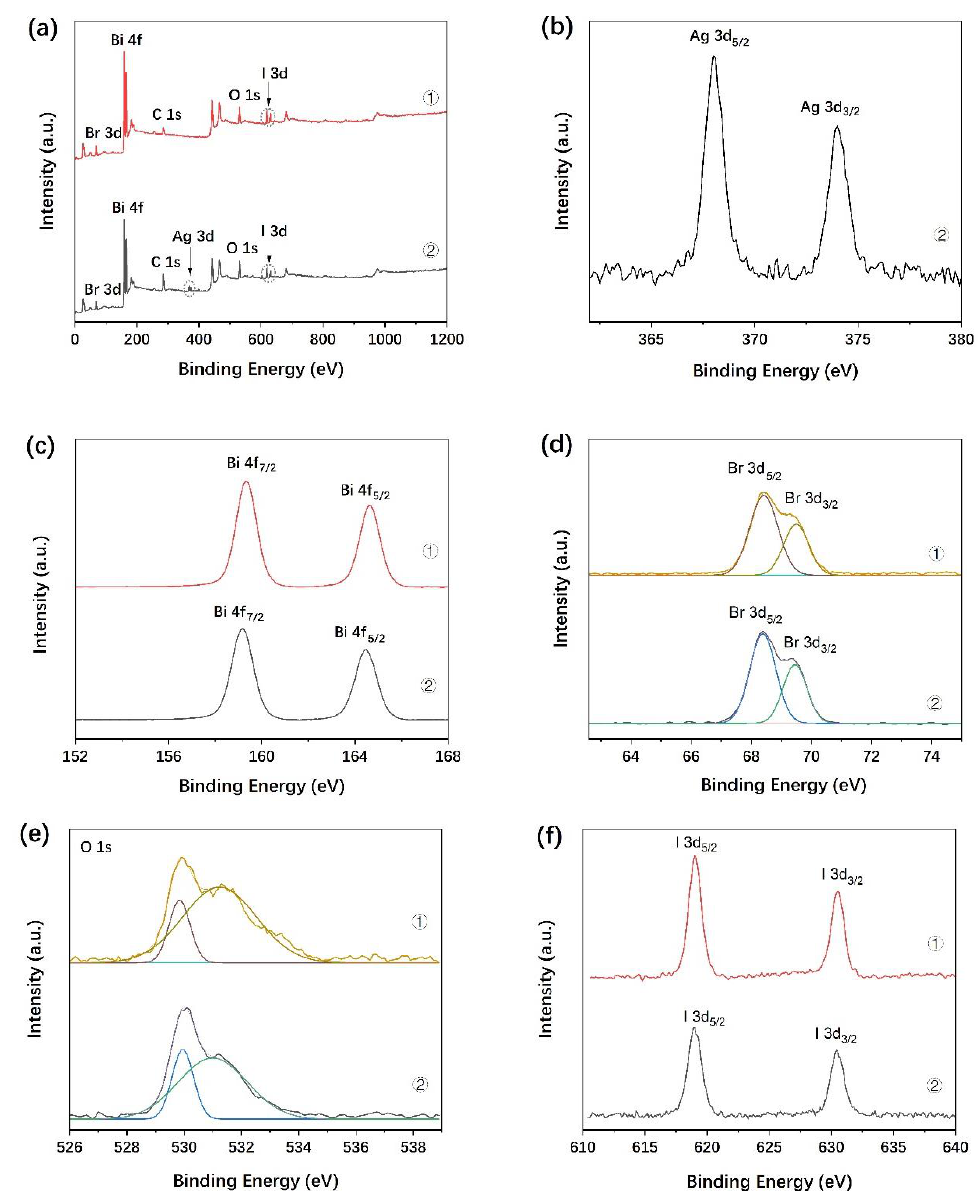
Figure 5. XPS spectra of BiOBr 0.85 I 0.15 (sample ① ) and 1.0%Ag/BiOBr 0.85 I 0.15 (sample ② ): survey spectra ( a ), Ag 3d ( b ), Bi 4f ( c ), Br 3d ( d ), O 1s ( e ), and I 3d ( f